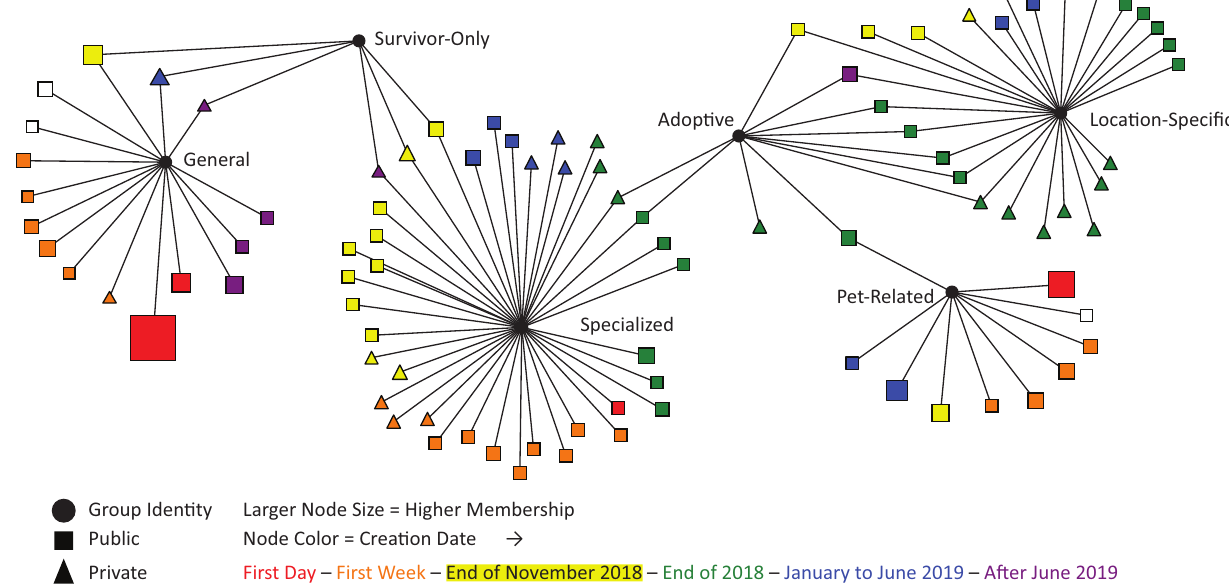
Figure 2. Network graph of CFFGs where ties represent holding a group